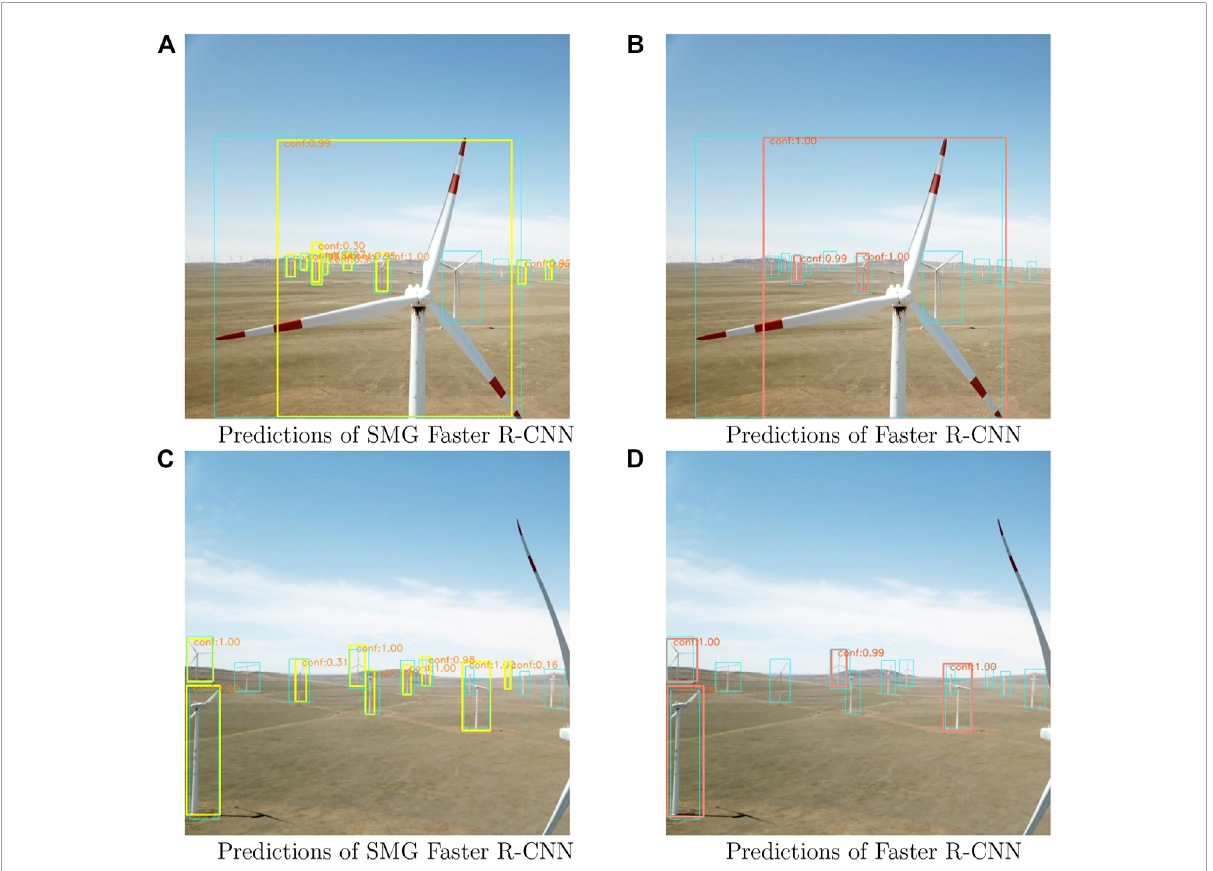
FIGURE 7 Predictions of SMG Faster R-CNN and Faster R-CNN. The cyan boxes are ground truth, yellow boxes mean predictions of SMG Faster R-CNN, and salmon boxes are predictions of Faster R-CNN. The “conf” in orange means the confidence score of the detected instance. (A) Predictions of SMG Faster R-CNN (B) Predictions of Faster R-CNN (C) Predictions of SMG Faster R-CNN (D) Predictions of Faster R-CNN.